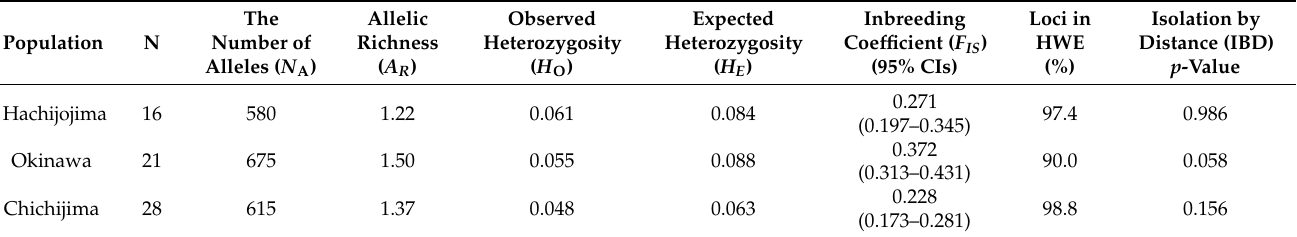
Table 1. Descriptive statistics of genetic diversity of T . brunneus for each population, generated from 428 SNPs. The number of colonies tested (one worker per colony) is indicated by N. Other statistics are described in Section 2.